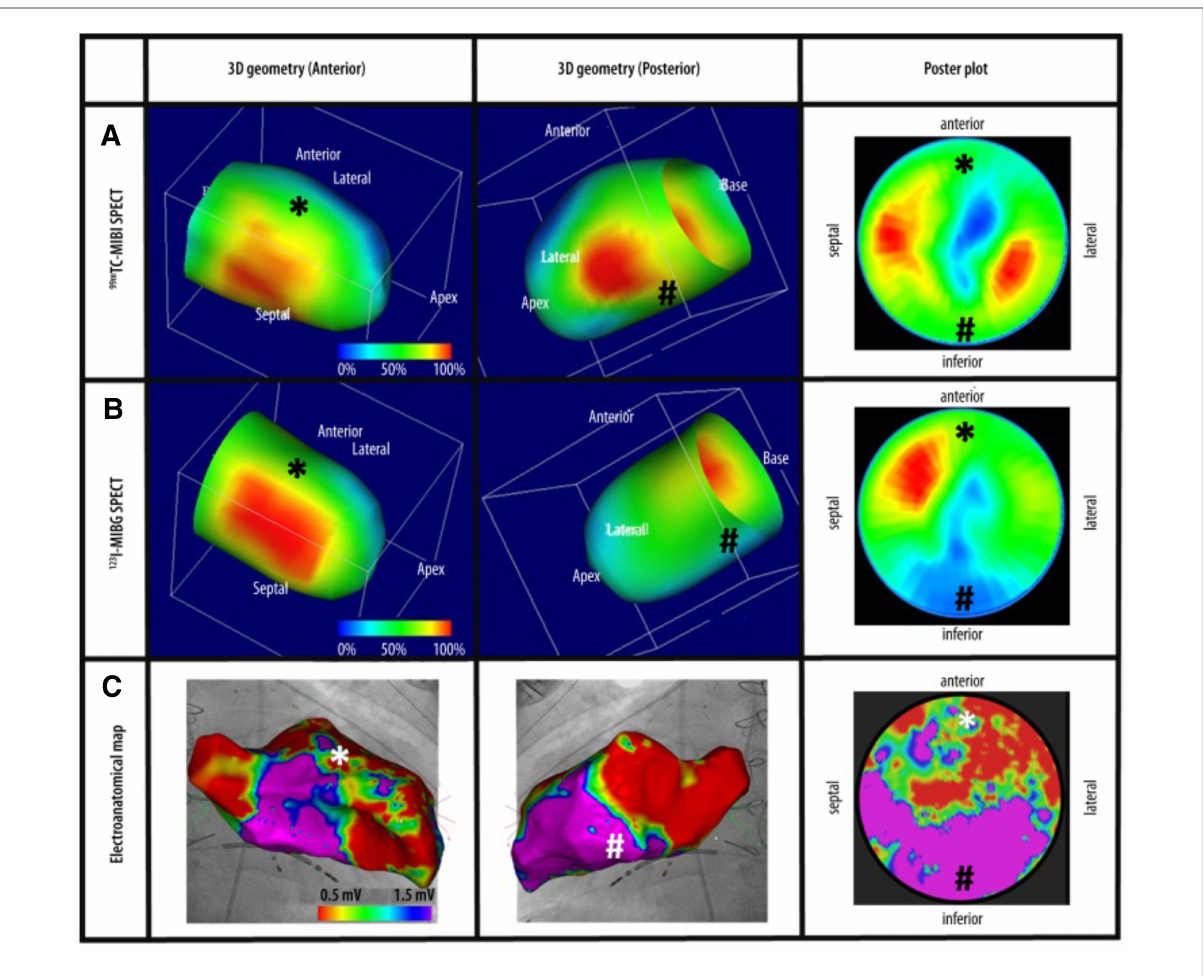
FIGURE 7 Cardiac imaging modalities combined. ( A ) Revoluntary Tc-99m-MIBI-SPECT imaging reveals anterior and inferior perfusion imaging. ( B ) I-123-MIBG- SPECT illustrates decreased sympathetic innervation at the inferior left ventricle. ( C ) Electroanatomical mapping shows extensive anterior left ventricle scarring recognized by low-voltage regions. Tc-99m-MIBI, Technetium-99m-sestamibi, I-123-MIBG, Sodium Iodide-123 Meta-Iodo- Benzyl-Guanidine